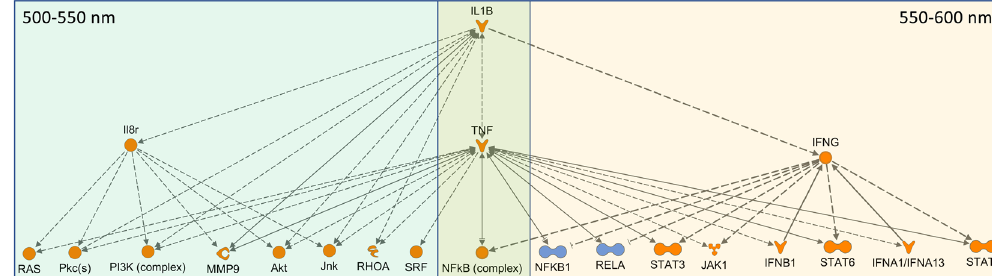
Figure 6. Upstream regulators modulated in liver by both FL and 500–550 nm (left) or 550–600 nm (right). IL1B, TNF and NFkB complex are up modulated following both wavebands. The 500–550 nm region on the left is primarily responsible for the up-regulation of cell cycle progression and DNA repair and the 550–600 nm region is primarily responsible for the immune and inflammatory response. Both are regulated and controlled by the IL1B regulator which is the top modulated regulator in the liver FL